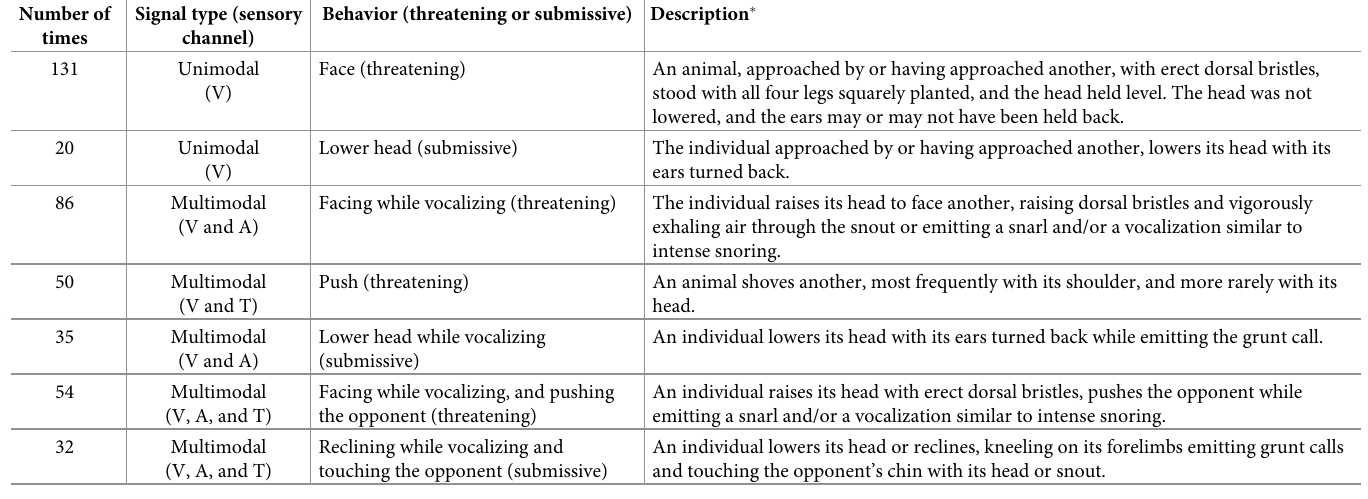
Table 2. Number of times each signal type (unimodal or multimodal), engaging different sensory channels of the receiver (visual- V, auditory- A, and tactile—T), was produced by white-lipped peccaries when displaying threatening and submissive behaviors. Number of Signal type (sensory times